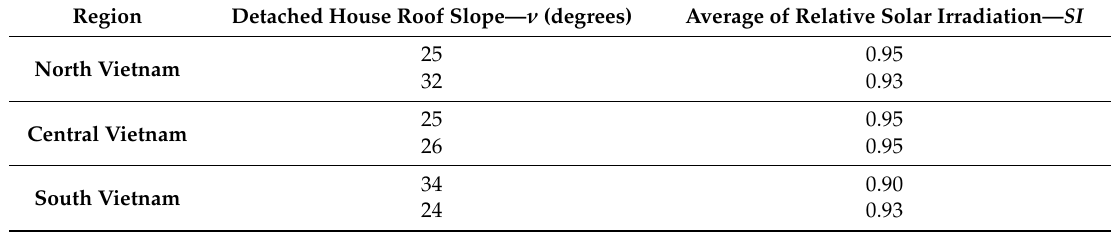
Table 1. Average of relative solar irradiation in accordance with di ff erent roof slopes in Vietnam. Region Detached House Roof Slope— ν (degrees) Average of Relative Solar Irradiation— SI 25 0.95 North Vietnam 32 0.93 25 0.95 Central Vietnam 26 0.95 34 0.90 South Vietnam 24